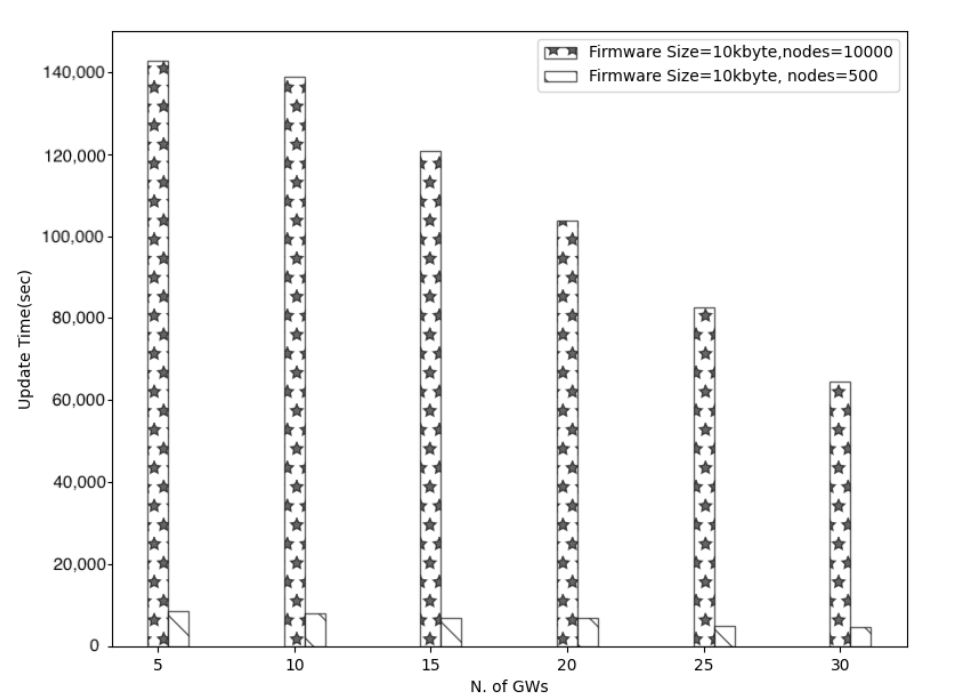
Figure 9. Update time vs. multiple Gws and number of